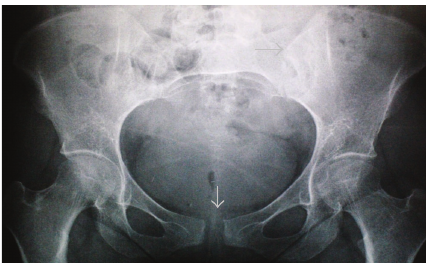
Figure 3: Anteroposterior radiograph of the pelvis demonstrating reduction of the pubic symphysis and left sacroiliac joint at 6 months